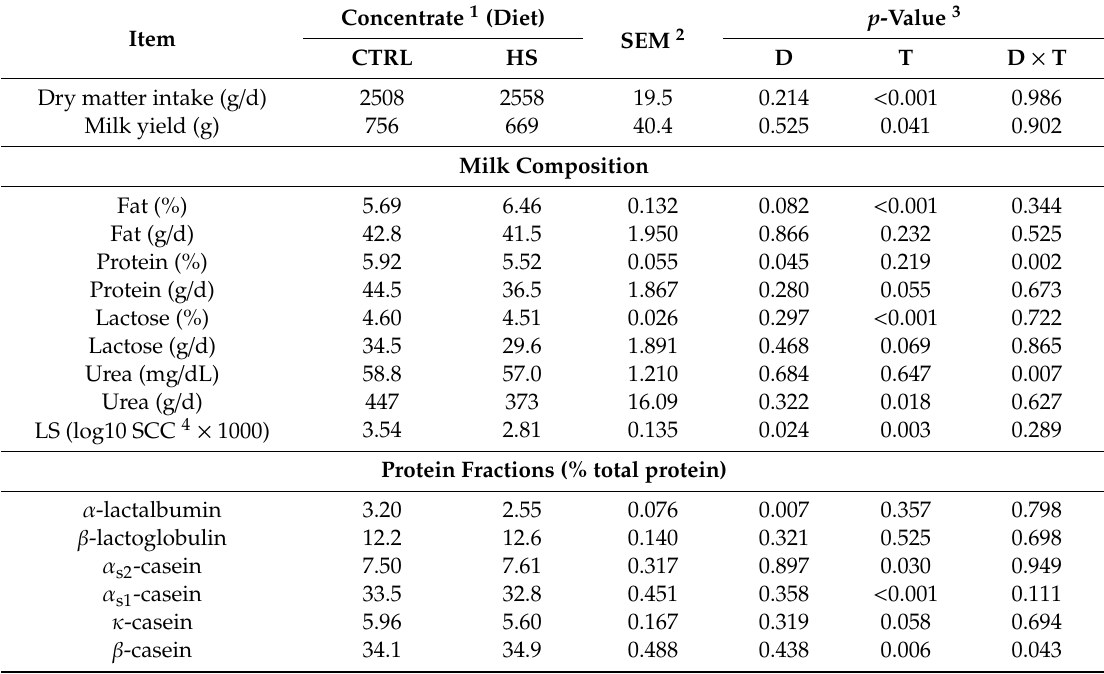
Table 2. The e ff ect of the dietary treatment on milk yield and